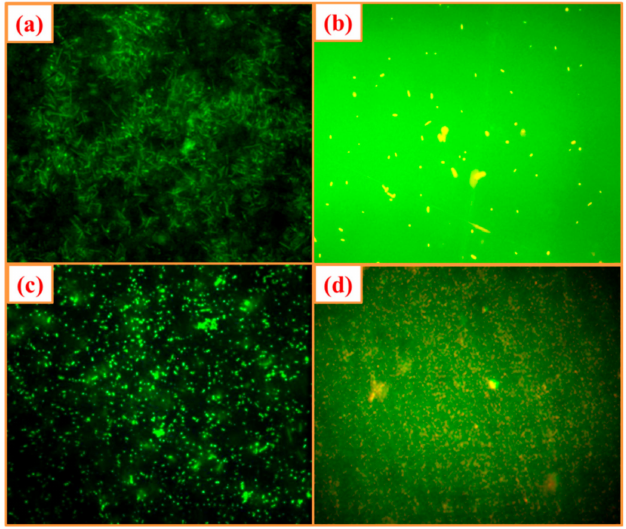
Figure 8. Fluorescent microscopic (40 × ) images of ( a ) E. coli and ( c ) S. aureus untreated control bacterial cells and ( b ) E. coli and ( d ) S. aureus treated with ZnO-NPs. In both series, green dots represent live bacterial cells and yellow / orange dots represent dead cells. Table 3. Comparison of obtained antibacterial results of prepared samples with the literature.